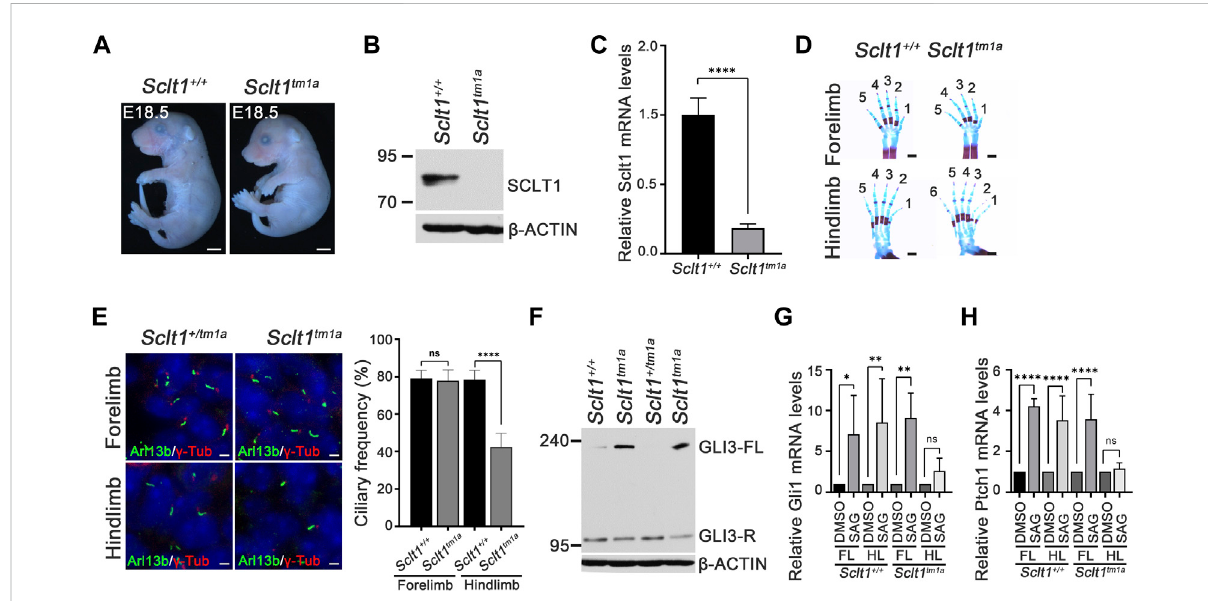
FIGURE 1 Sclt1 mutant mice display hindlimb-speci fi c preaxial polydactyly caused by disruption of ciliogenesis and Hh signaling (A) Gross morphological analysis of Sclt1 tm1a and wildtype control littermates at stage E18.5. Scale bars = 1 mm (B) Western blot analysis to detect levels of SCLT1 from E10.5 whole embryo extracts. Signal speci fi c to anti-SCLT1 antibody is undetectable in Sclt1 mutant embryos, compared with wildtype control (C) Quantitative RT-PCR (qRT-PCR) analyses with RNAs from whole embryos at E10.5 con fi rmed that expression levels of properly spliced full- length transcripts were lower than those of wildtype transcripts (D) Alcian blue/alizarin red staining of limbs in E18.5 embryos. Hindlimbs of Sclt1 mutant had abnormal digit patterning such as preaxial polydactyly (E) Left panel, representative immuno fl uorescence image of co-staining with ciliary marker, Arl13b (Arl13b, green), and basal body marker, gamma-tubulin ( γ -Tub, red). Right panel, quantitative analysis of ciliogenesis from immuno fl uorescent stained Sclt1 mutant and control limb buds. Error bars represent SEM and asterisk denotes statistical signi fi cance, based